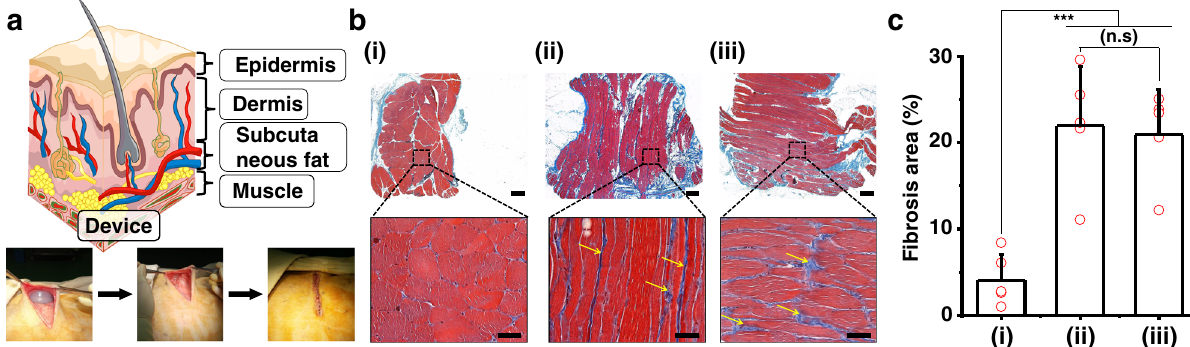
Fig. 5 Biocompatibility of the encapsulated I-TENG. a Schematic image of the implanted device under the subcutaneous fat of the mongrel model. b Masson ’ s trichrome stain results of (i) no in fl ammatory cells and scanty amount of perivascular fi brosis observed in normal muscle; (ii) prominent fi brosis and a mild in fl ammatory response around the encapsulated device; and (iii) similar fi brosis and in fl ammatory response around a commercial medical device. Red, white, and blue represent normal muscle, fat, and infection, respectively. Yellow arrow was analyzed by randomly selecting each of fi ve groups in sections of tissue implanted. scale bar, 1 mm. Inset fi gures scale bar, 50 µ m. The Masson ’ s trichrome stain results randomly selected fi ve groups of three different conditions. c Comparison of fi brosis area (%) of (i) normal muscles, (ii) muscle tissue around the encapsulated device, and (iii) muscle surrounding the commercial medical device, determined using ImageJ software. n = 5, p value = 0.0002, one-way ANOVA. Error bars correspond to standard deviations.